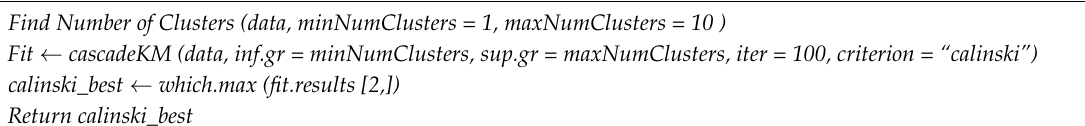
Algorithm 1. Optimal number of clusters using Calinski-Harabasz criterion.